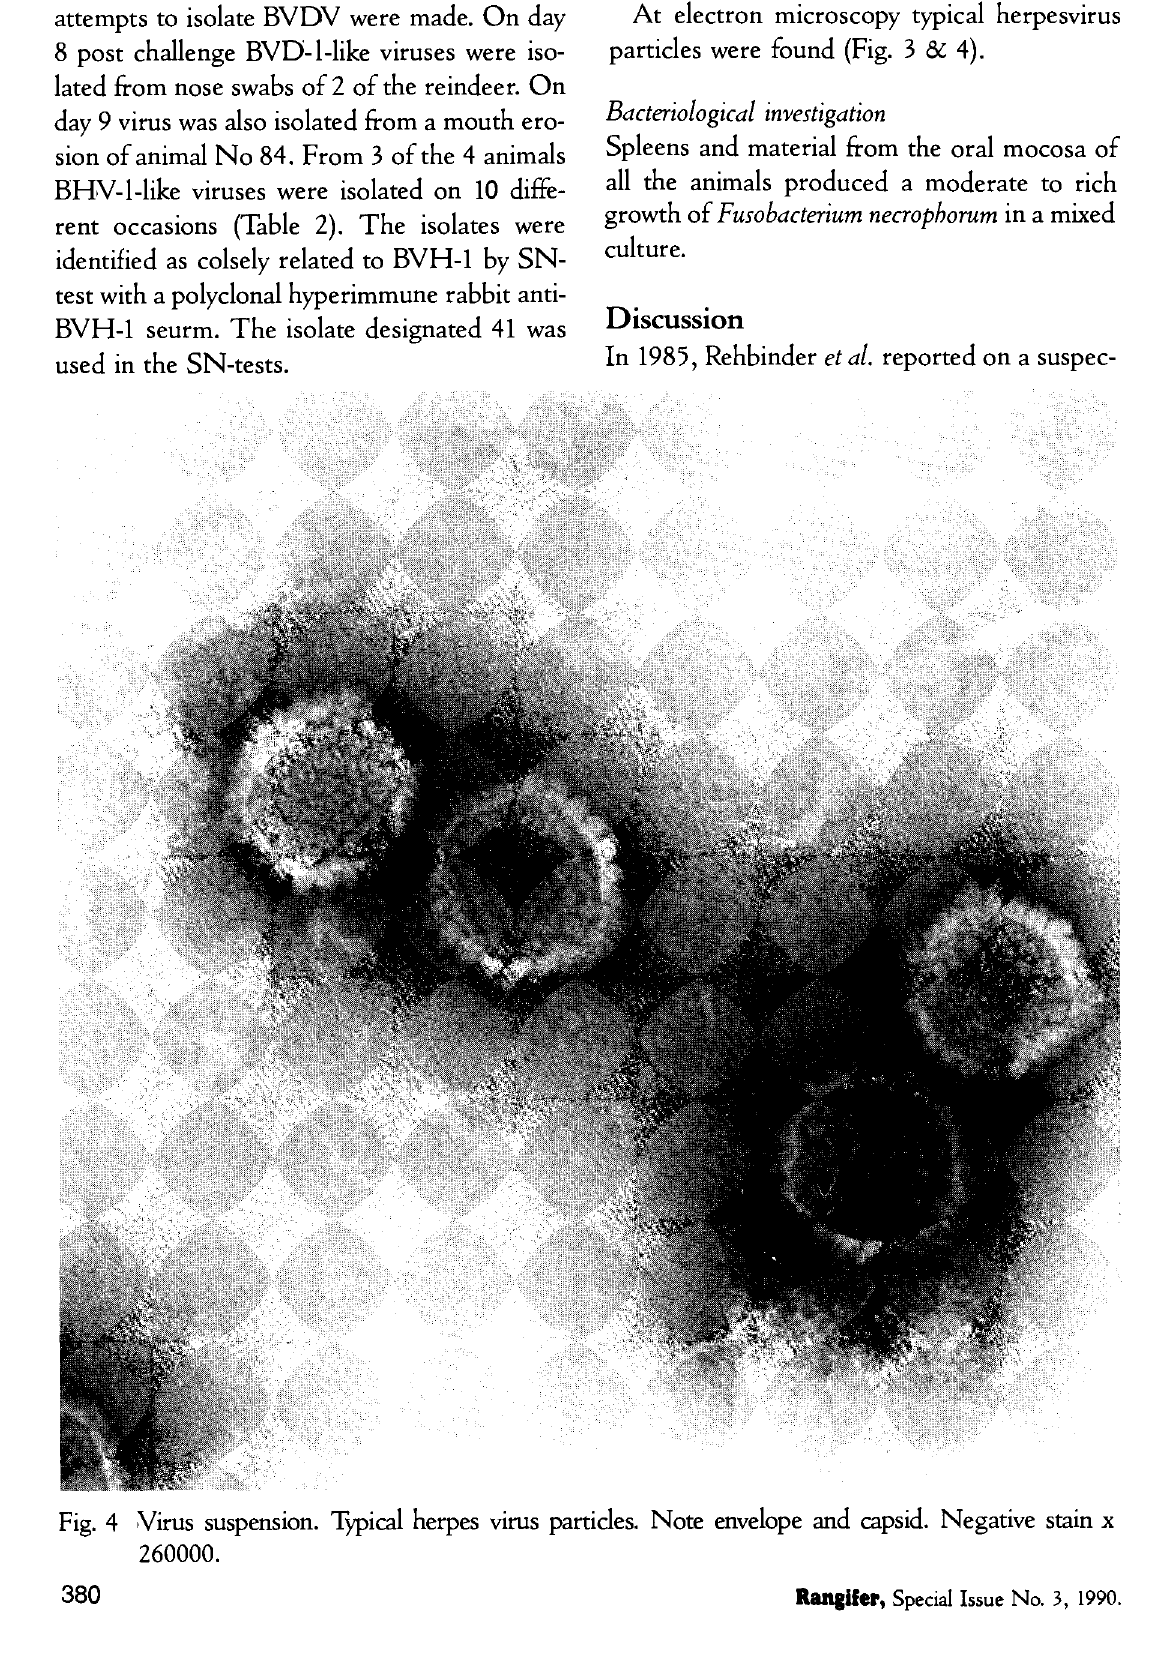
Fig. 4 Virus suspension. Typical herpes virus particles. Note envelope and capsid. Negative stain x